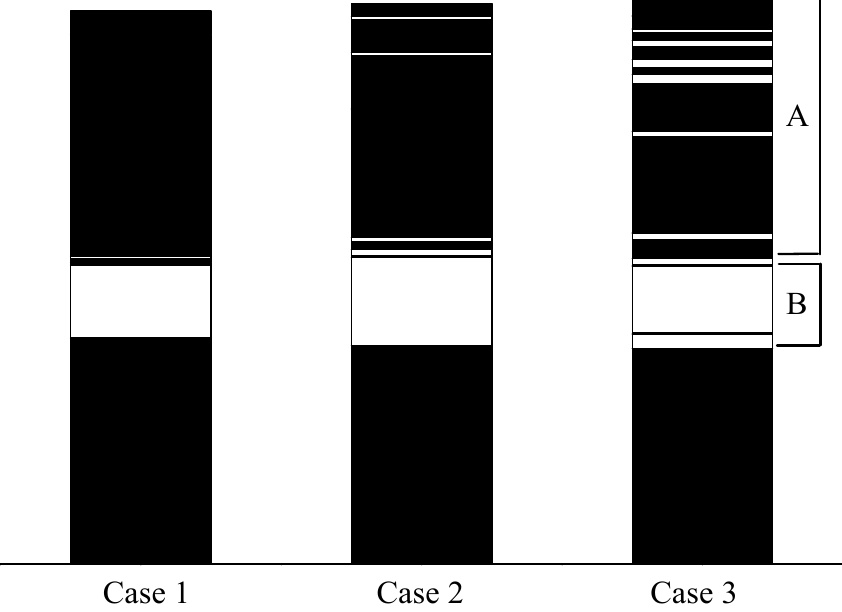
Figure 11. Distribution of ice lenses at different initial void ratios. (Region A is called the ‘previous ice lenses’; Region B is called the ‘stable ice lens’.).